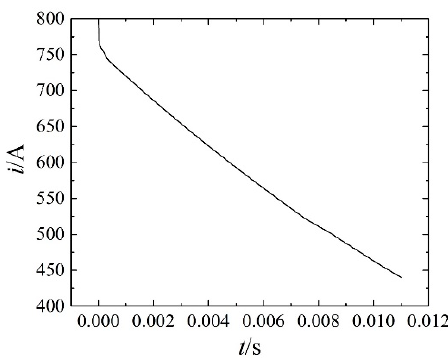
Figure 14. Arc current curve (DC 1500 V, I = 800 A) .